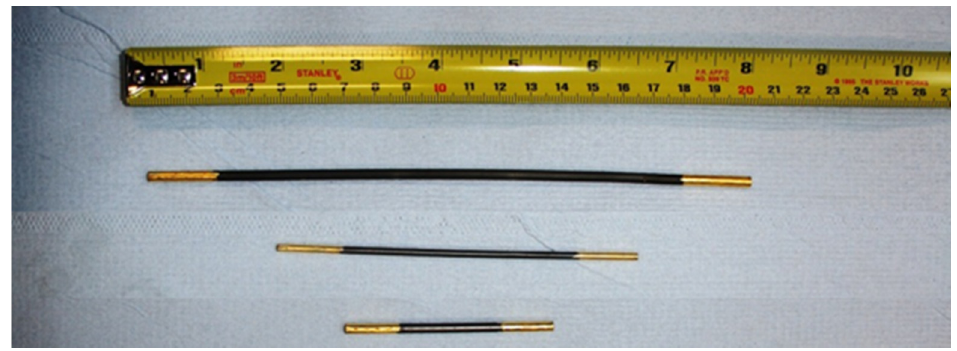
Figure 3. Snapshot of perovskite membranes prepared for the DEMCAMER project already sealed with a gold layer [35].